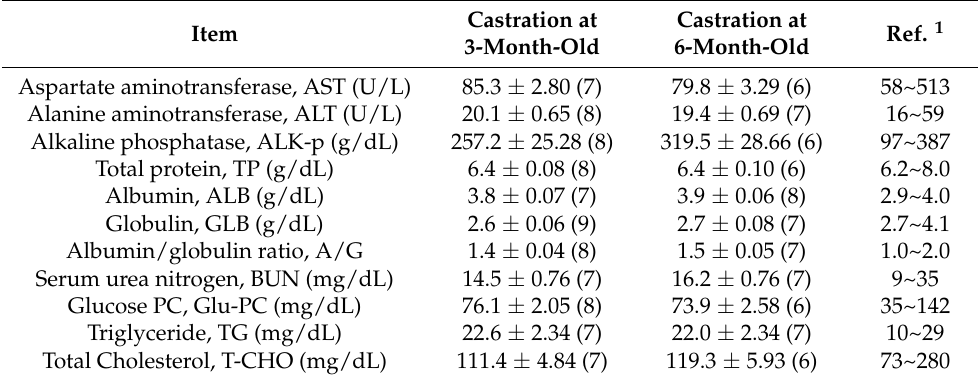
Table 5. Effects of castration at different ages on serum-blood biochemistry parameters in Nubian crossbred wethers at the end of the fattening period (LSM ±